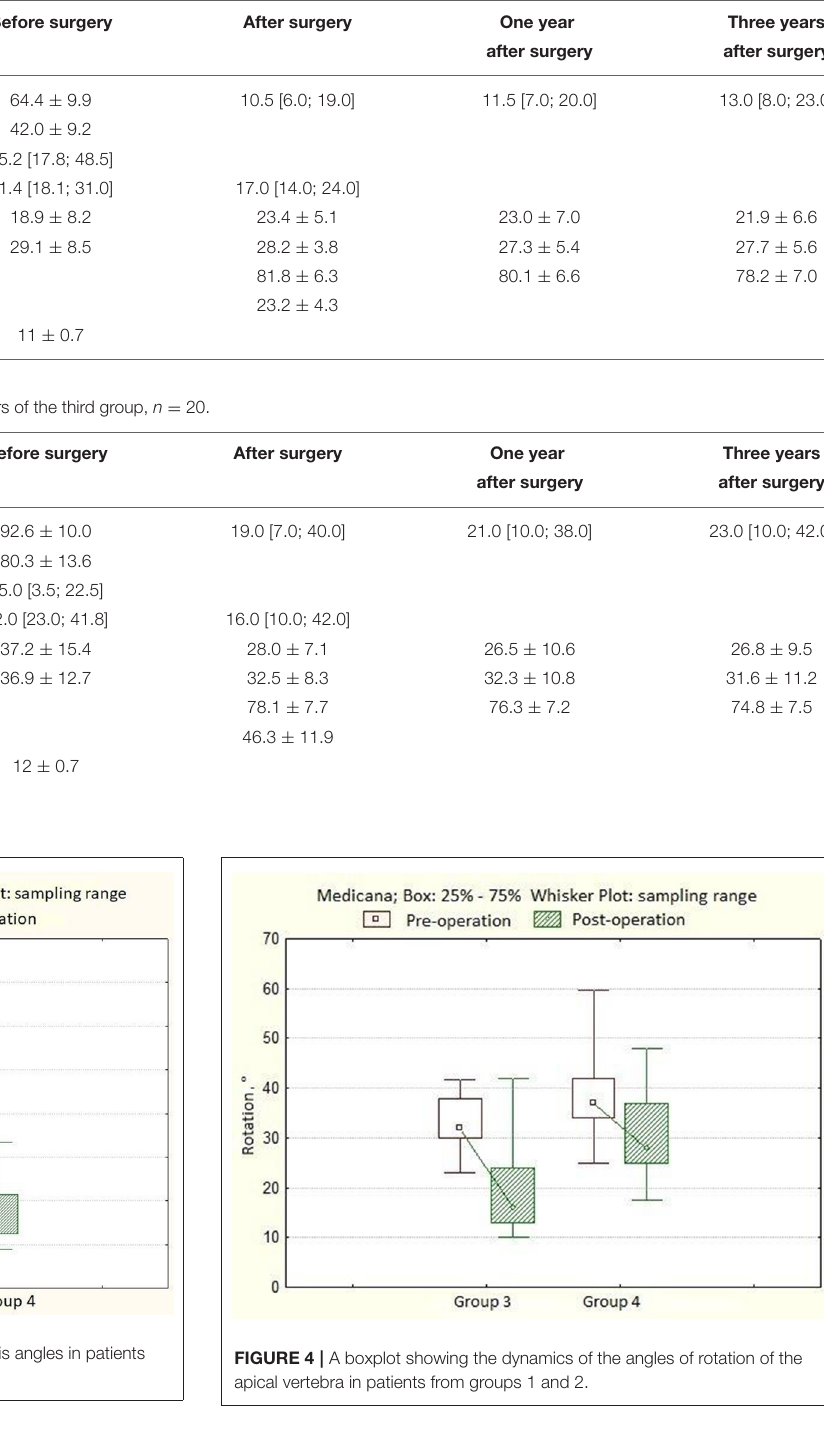
3.8 ◦ . The rotation of the apical vertebra was 17.0 ◦ ± 1.9 ◦ (14.0 ◦ - 24.0 ◦ ), the percentage of derotation was 23.2 ± 4.3% ( Figure 2 ). The length of the metal structure is 11 ± 0.7 (10–12), vertebrae.